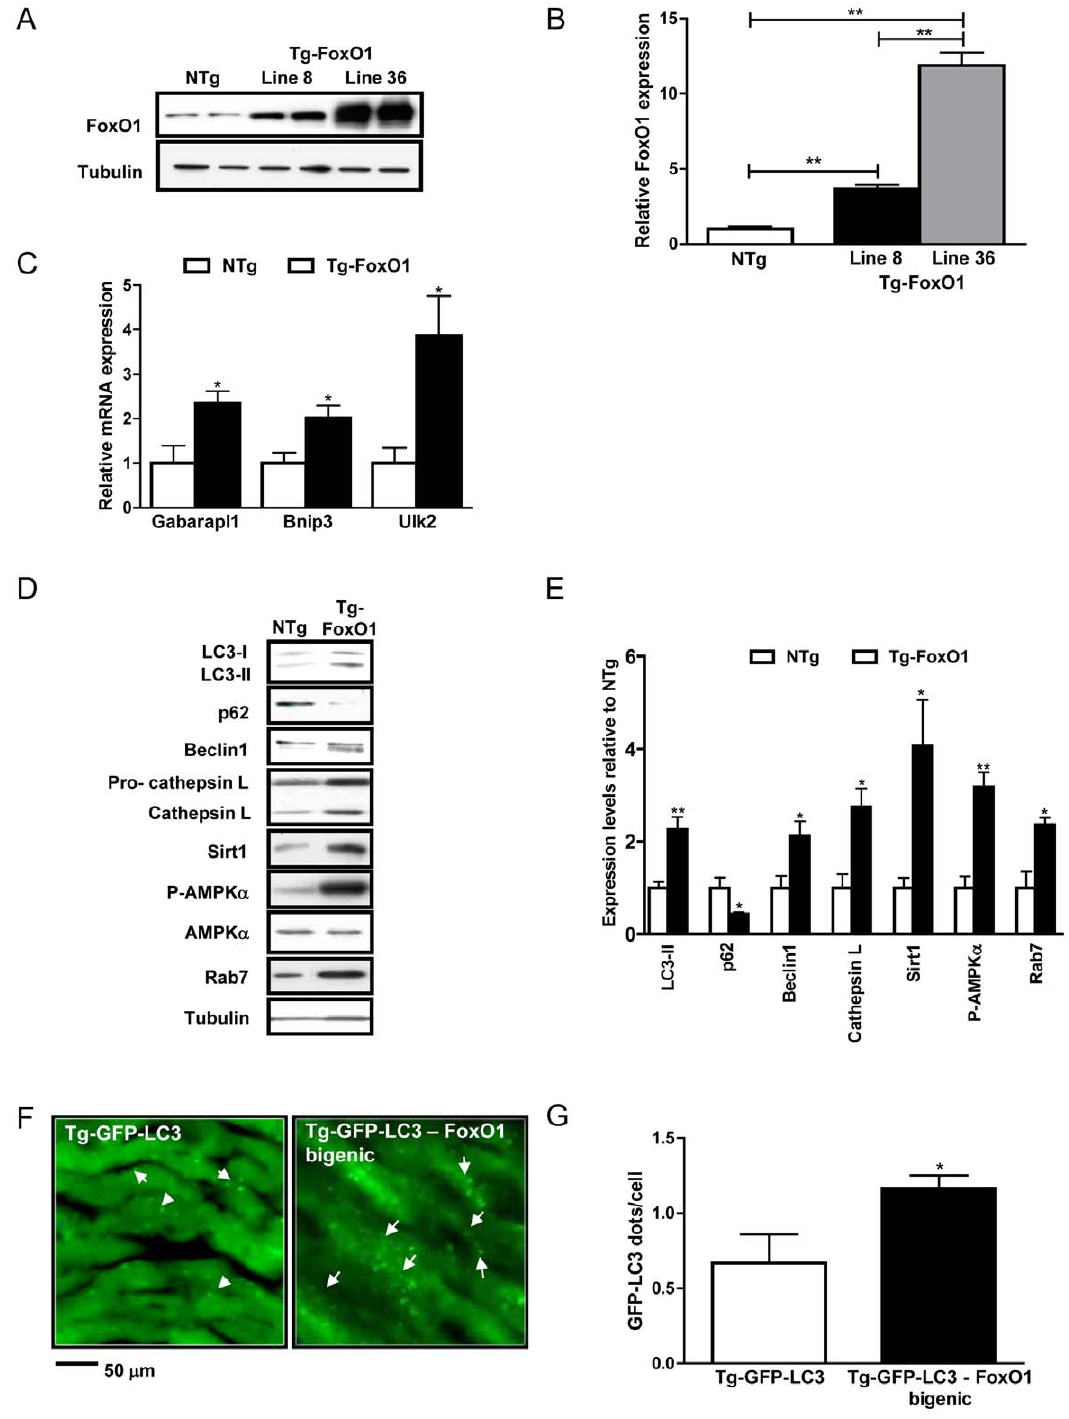
Figure 3. Overexpression of FoxO1 regulates autophagy invivo. Transgenic mice with cardiac-specific overexpression of WT-FoxO1 (Tg- FoxO1) were generated. A) Representative immunoblots comparing FoxO1 expression levels in the two lines (lines # 8 and # 36) of Tg-FoxO1 and nontransgenic (NTg) mice. B) Densitometric analyses. C) mRNA levels of autophagy genes Gabarapl1, Bnip3 and Ulk2. D) Representative immunoblots of autophagy markers. E) Densitometric analyses. F–G) Tg-FoxO1 mice were bred with Tg-GFP-LC3 to generate Tg-GFP-LC3 – FoxO1 bigenic mice. F) Representative images of GFP-LC3 puncta. Arrows indicate LC3 puncta. G) Mean number of GFP-LC3 dots/cell. Data represent means from at least 4 individual mice. * p , 0.05, ** p , 0.01.